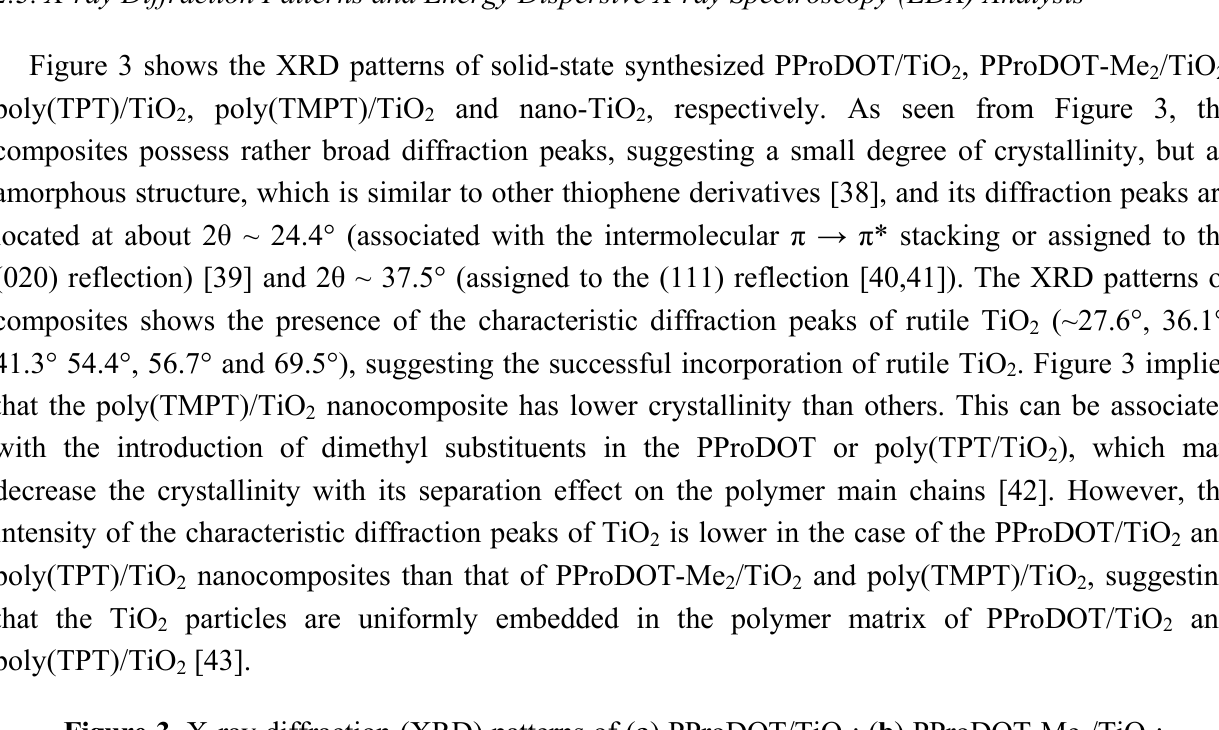
Figure 3. X-ray diffraction (XRD) patterns of ( a ) PProDOT/TiO